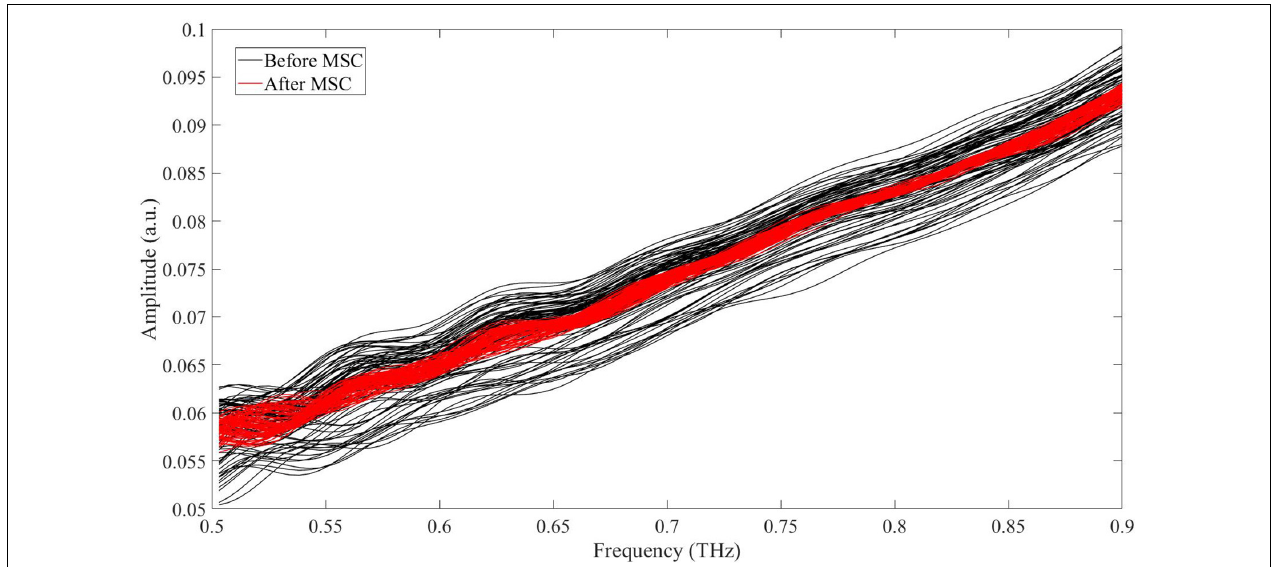
FIGURE 4 | Extinction coefficient of samples in Group 2 before and after MSC.